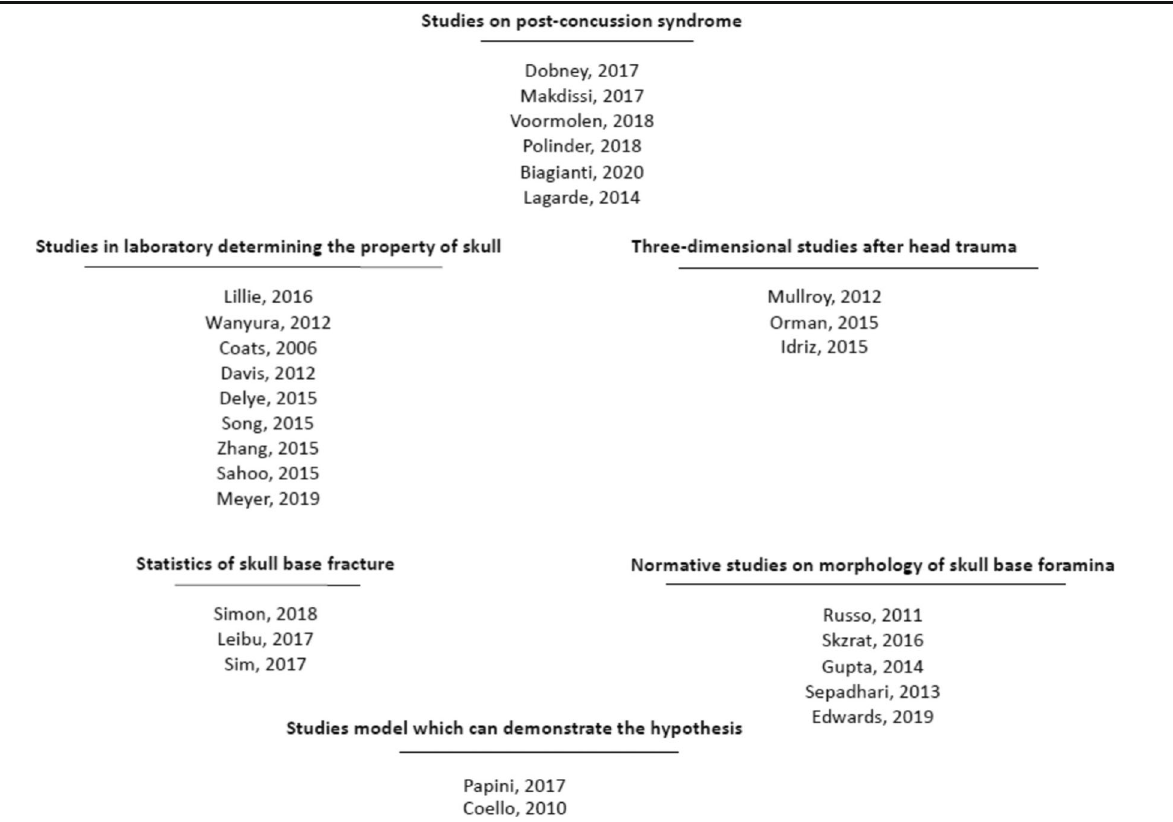
Table 2 Results of search strategy using the PICO